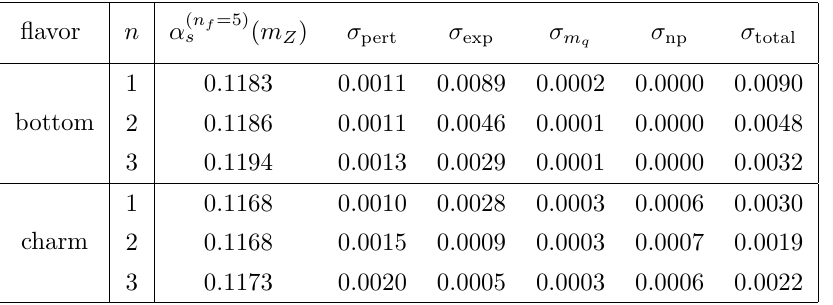
Table 8 . (cid:11) ( n f =5) s ( m Z ) determination from ratios of bottom and charm vector-correlator moments R V;n , eq. (2.6). The (cid:12)rst column speci(cid:12)es the (cid:13)avor content of the current, the second column q shows which ratio has been used, while the third gives the central value. Fourth to seventh provide the various components of the uncertainty: scale variation ( (cid:27) pert ), experimental ( (cid:27) exp ), quark mass ( (cid:27) m ), and gluon condensate ( (cid:27) np ), which are added in quadrature in the last column ( (cid:27) tot ). q (cid:11) dependence of the experimental moments, given in table 6, solving the relevant s